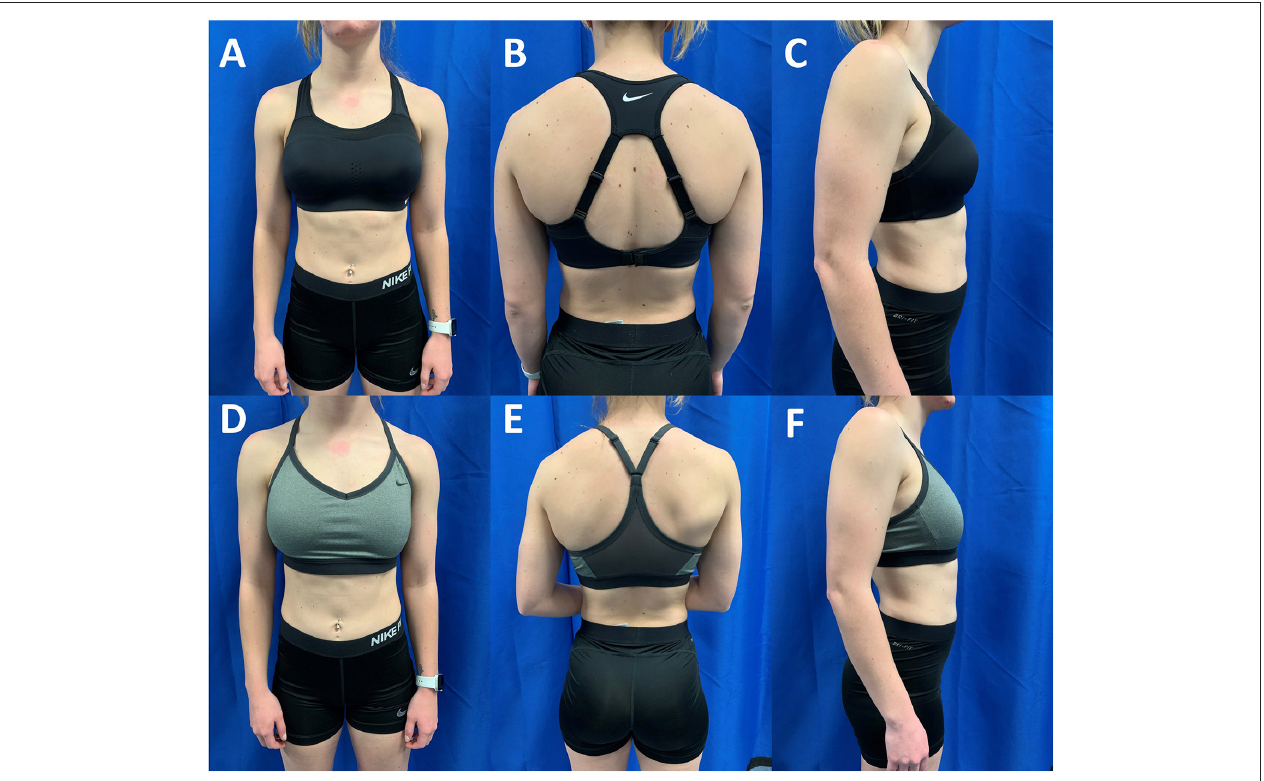
FIGURE 1 | Anterior, posterior and lateral views of a participant with D-Cup sized breasts in the high support Nike Alpha (A–C) and low support Nike Indy (D–F) . The athlete was classified as a D-Cup based on the difference between her bust and underbust circumferences (Bust: 84cm; Underbust: 73.5cm; Difference: 10.5cm). The high support sports bra is designed to lift and compress the breast tissue while the low support sports bra is not designed with these features.